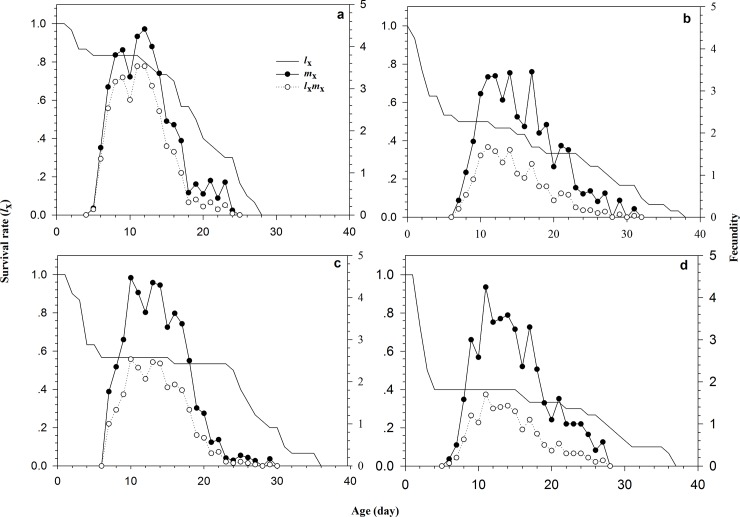
Age-specific survival rates (lx), age-specific fecundity (mx) and net maternity (lxmx) of Rhopalosiphum padi, the parental females of which were exposed to wheat leaves treated with different concentrations of imidacloprid.(a) Control, (b) LC10, (c) LC20, (d) LC25.